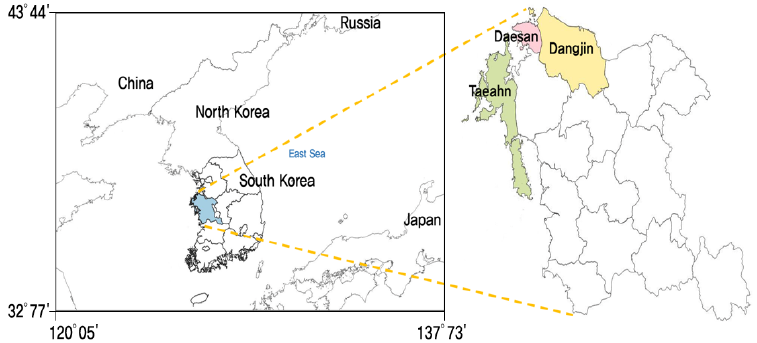
Figure 1. Location of large point-source particulate matter (PM) pollutants (i.e., Daesan industry complex) and coal-power plants (at Dangjin and Taeahn) in Chungcheongnoam-do (CN).